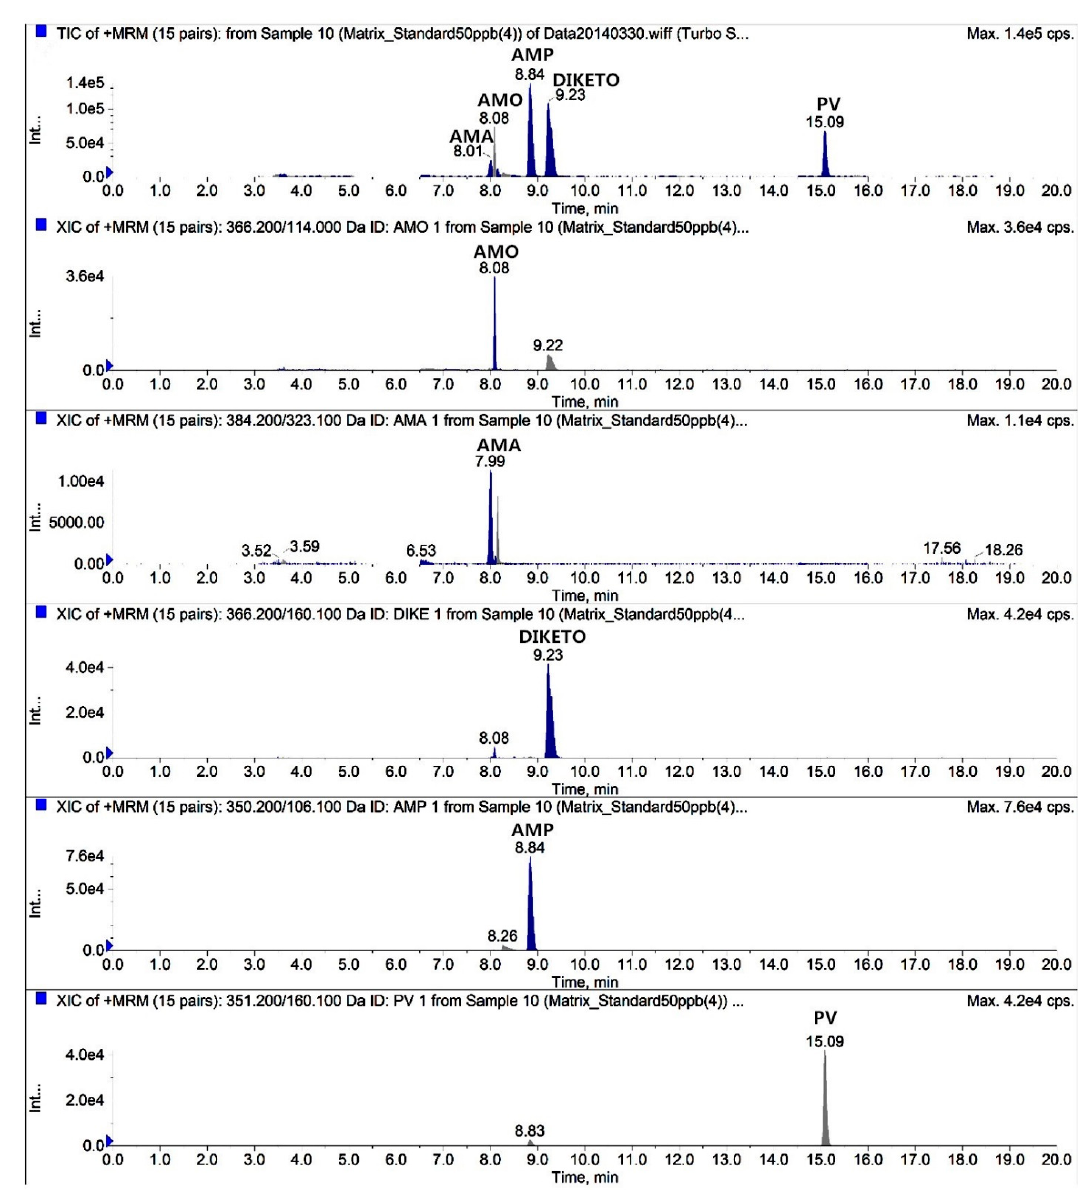
Figure 3. TIC and XICs of blank chicken muscle samples spiked with 50 μ g/kg AMO, AMA, DIKETO, and AMP and 125 μ g/kg PV.